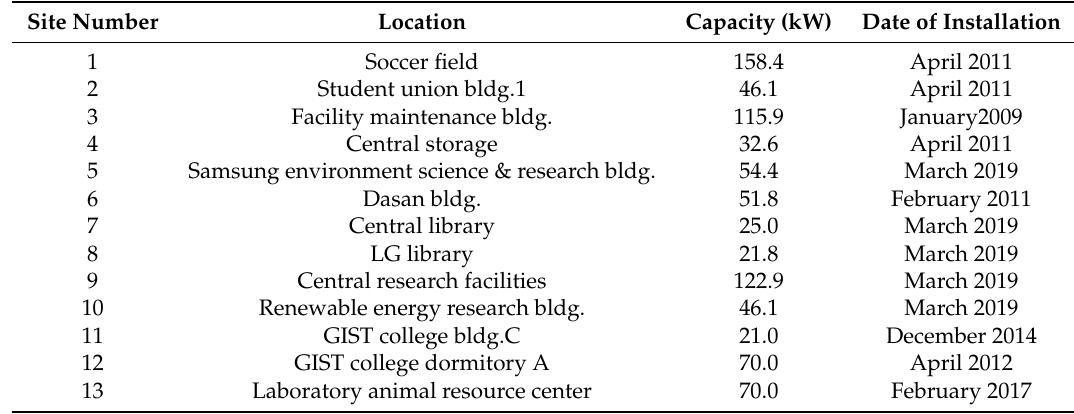
Figure 1. Weather stations and photovoltaic (PV) fleet on the Gwangju Institute of Science and Technology (GIST) campus. Table 1. Installation information for rooftop PVs in the GIST